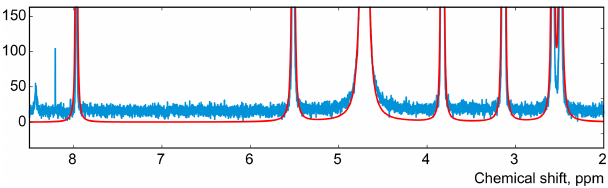
Figure 7. The spectrum of thiamine after phase adjustment accord- ing to the proposed rule (cf. Fig.